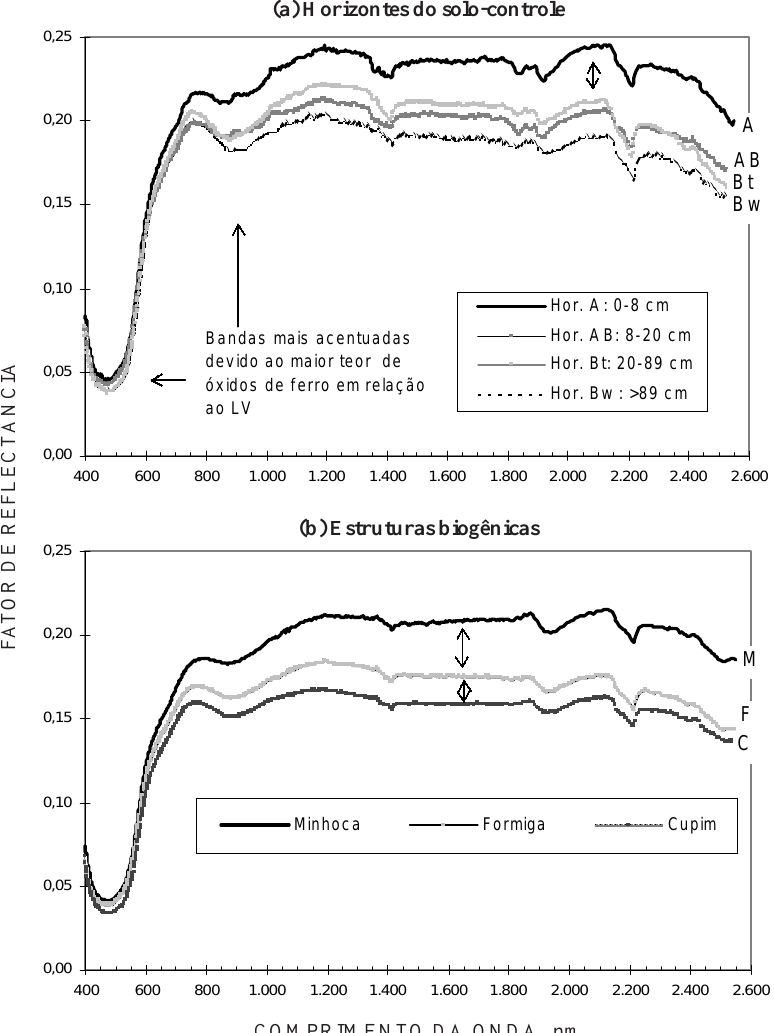
Figura 5. Comportamento espectral dos horizontes da Terra Roxa Estruturada latossólica (a) e das estruturas biogênicas